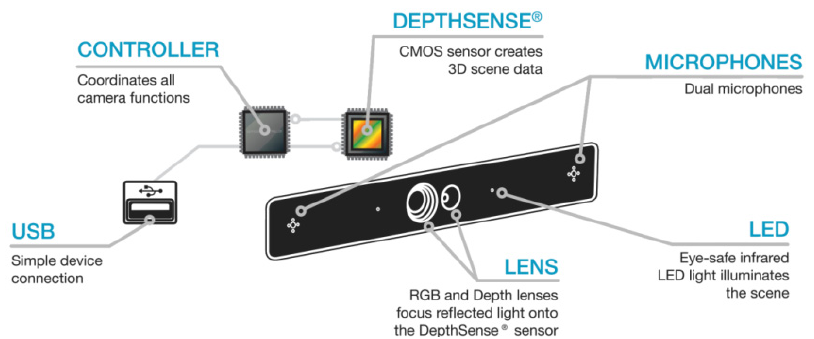
Figure 1. DS311 internals and technology.